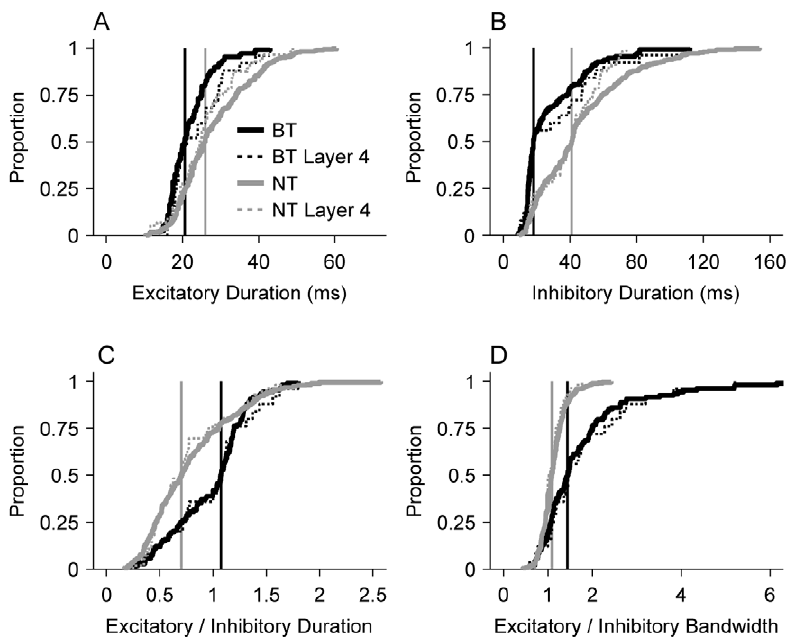
Figure 5. Comparison between BT and NT neuron STRF subfield duration and bandwidth. (A) Cumulative distribution function (CDF) of excitatory subfield durations. Solid lines represent total population data. Vertical lines indicate population medians. Dashed lines represent values exclusively from layer 4 neurons (800–1100 m m cortical depth). NT neurons have significantly longer excitatory subfield durations (p , 0.001, KS-test). (B) CDF of inhibitory duration. BT neurons had shorter inhibitory subfields (p , 0.001, KS-test). (C) CDF of the ratio of excitatory to inhibitory duration. For BT neurons, the temporal duration of excitation is similar to the duration of inhibition (p , 0.001, KS-test). (D) CDF of the ratio of excitatory to inhibitory bandwidth. For BT neurons, excitatory bandwidth was greater than inhibitory bandwidth. For NT neurons, the bandwidths were similar (p , 0.001, KS-test).